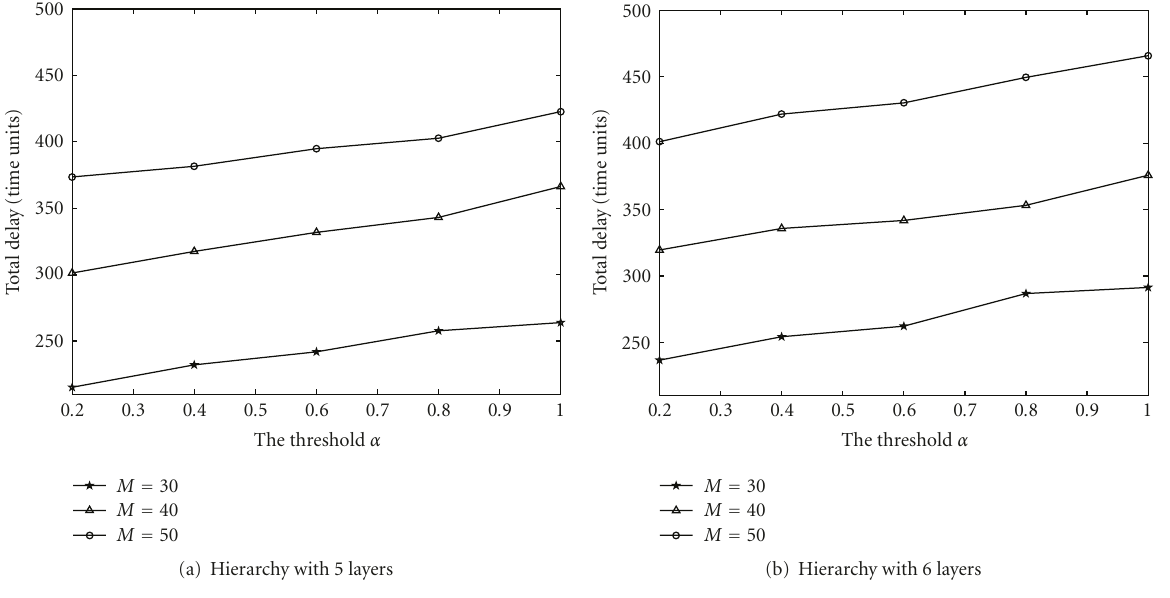
Figure 9: The total delay (time units) versus the threshold α .